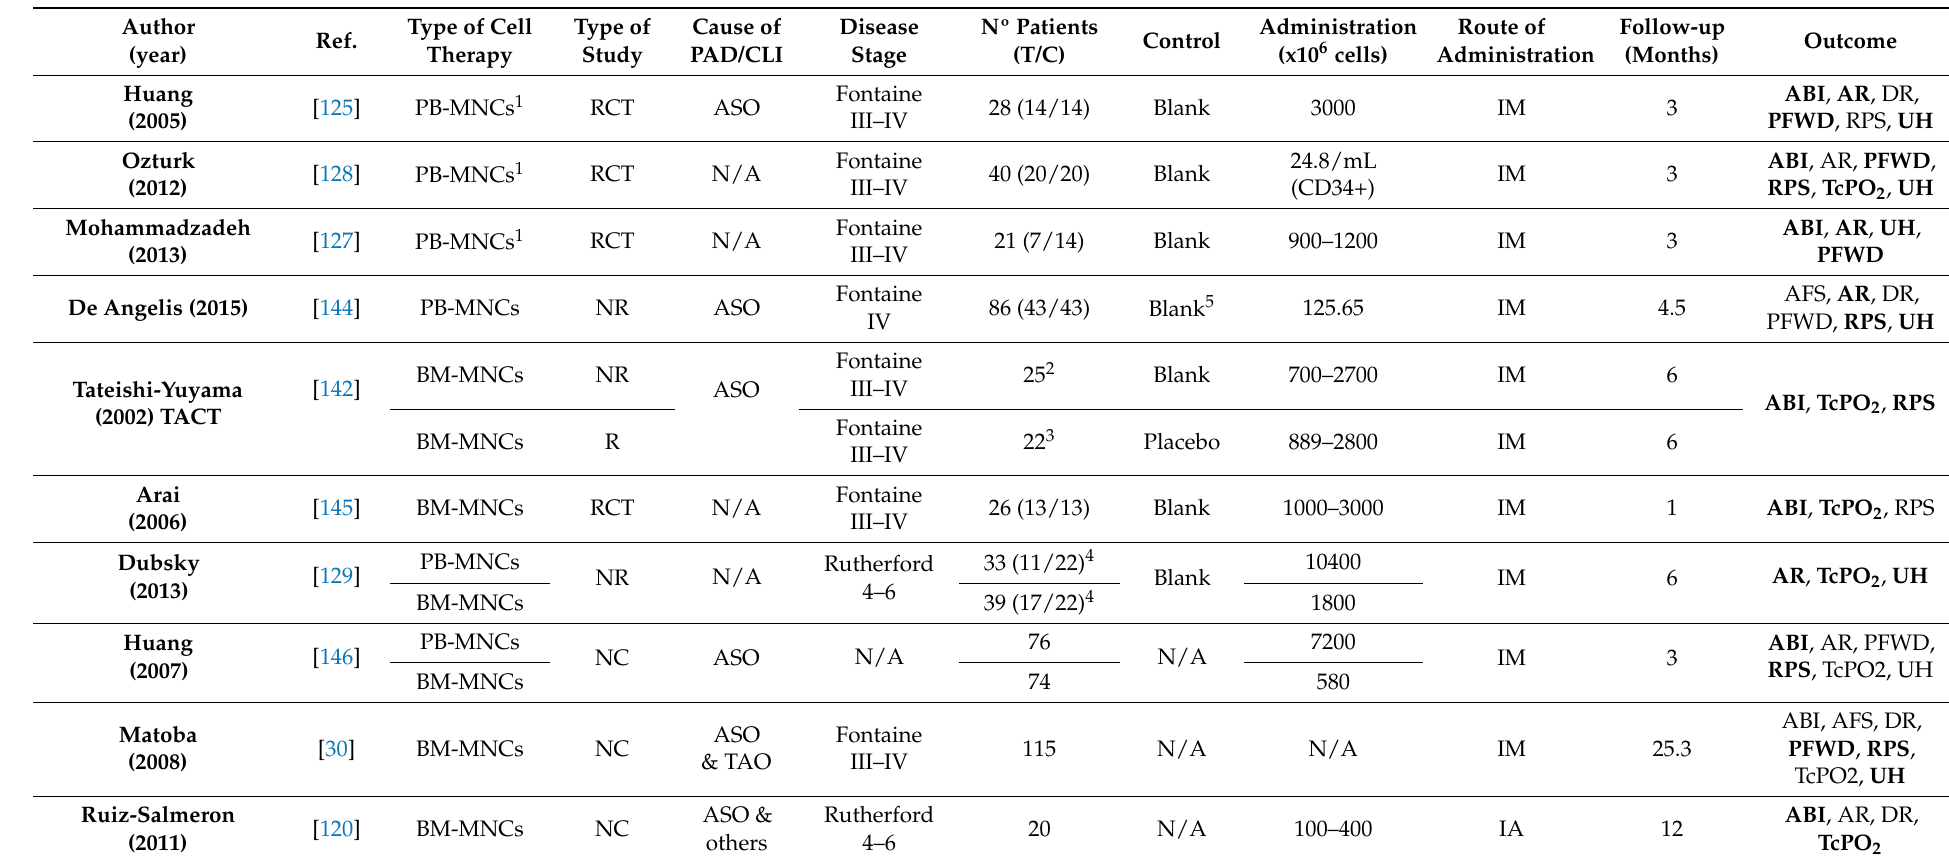
Table 2. Classification of most important cell therapy clinical trials. The table shows first author and year of publication, reference number (ref), type of cell therapy, type of study, associated cause of PAD/CLI, disease stage, number of patients (T=Treated/C=Controls), control used, number of administered cells, route of administration, follow-up, and parameters checked to evaluate the cell therapy outcome. Parameters registering general improvement vs. baselines/controls are highlighted ( bold ). Abbreviations included (alphabetical order): ABI: Ankle-brachial index; AFS: Amputation-free survival; AR: Amputation rate; ASO: Arteriosclerosis obliterans; DR: Death rate; ECEPCs: enriched circulating endothelial progenitor